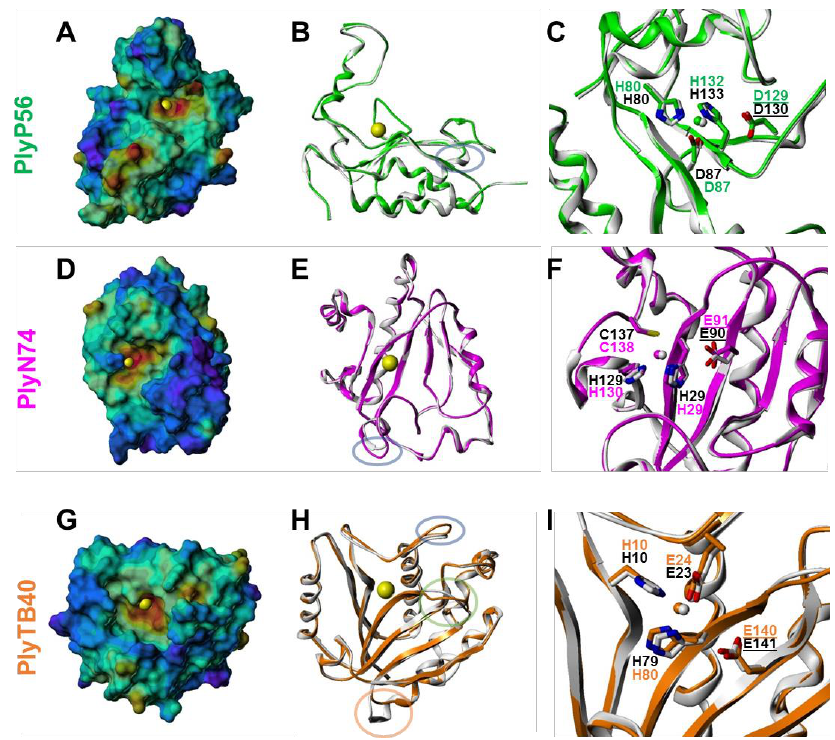
Figure 5. Homology models of PlyP56 ( A – C ), PlyN74 ( D – F ), and PlyTB40 ( G – I ) EADs. ( A , D , G ) Connolly surface representations color-coded by electrostatic potential (blue = most positive; red = most negative). A yellow sphere represents the Zn 2+ ion. ( B , E , H ) Ribbon representations of the homology modeling template (PlyP56: PDB ID = 2VO9; PlyN74: PDB ID = 1YB0; PlyTB40: PDB ID = 1XOV; white) and target (PlyP56, green; PlyN74, magenta; PlyTB40, orange) EADs illustrating the putative protein fold conservation. Colored ovals represent sequence insertions or deletions; see Figures S1–S3. ( C , F , I ) Catalytic active site amino acid residues. Residue label colors represent template (black) and target (PlyP56, green; PlyN74, magenta; PlyTB40, orange) EADs. An underline indicates the catalytic base/acid. Small spheres represent the Zn 2+ ion.